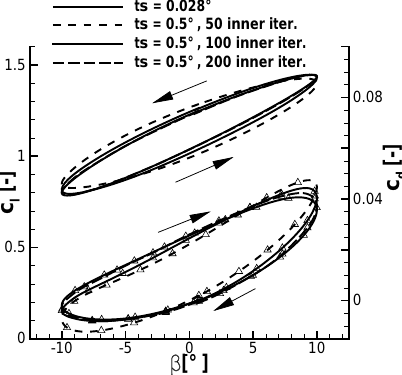
Figure 7. Influence of inner iterations in 2-D, lift (no symbol) and drag (symbol (cid:52)